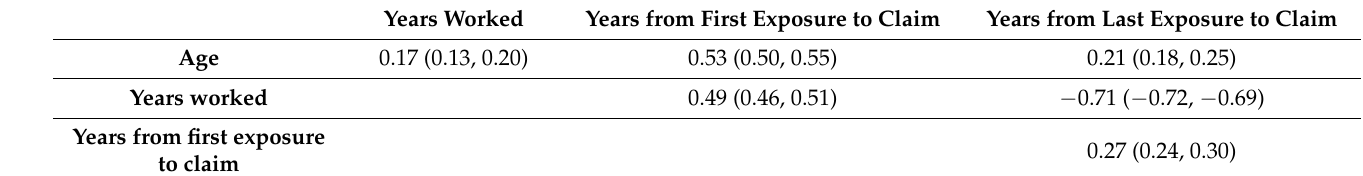
Table 2. Correlation between covariates with 95% confidence intervals.